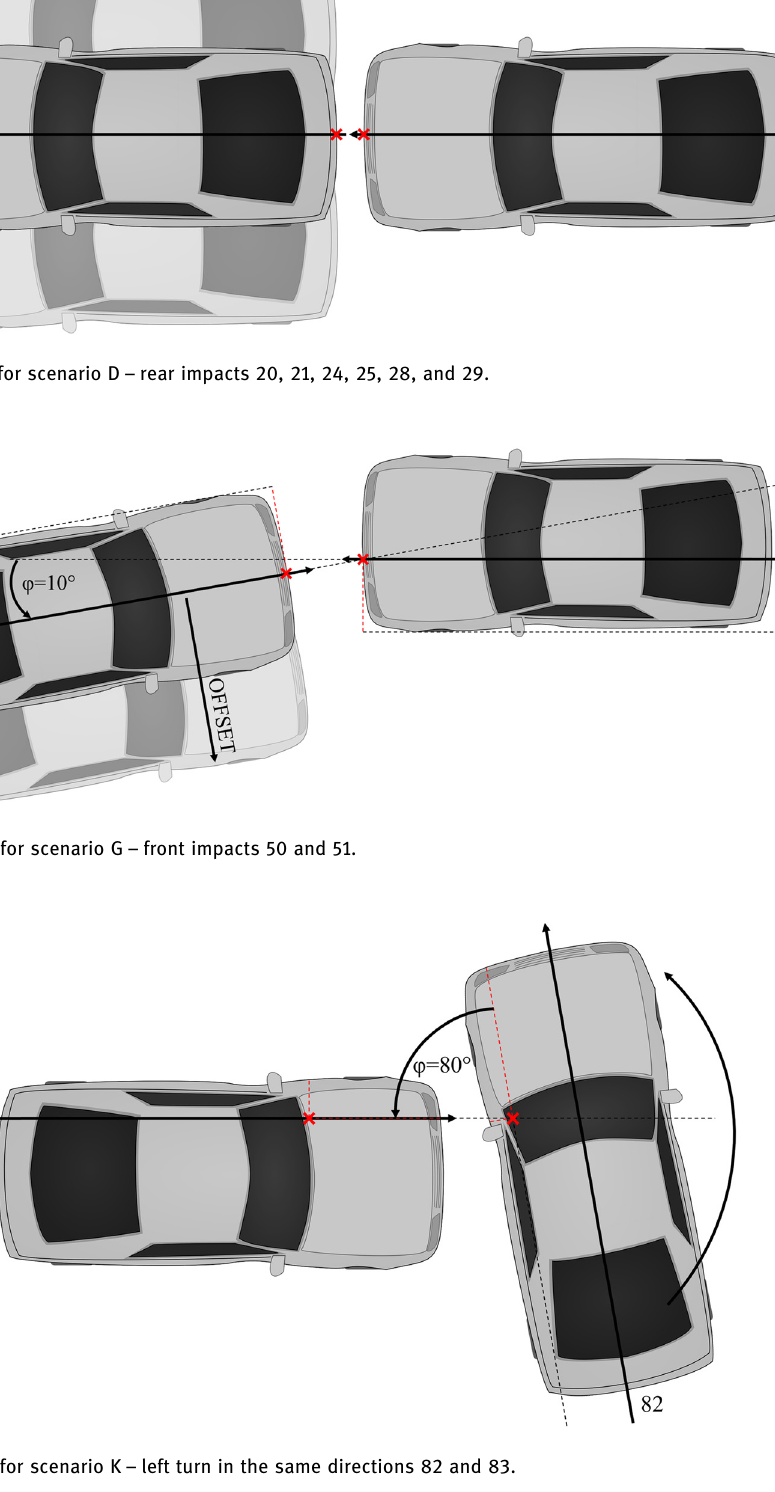
Figure A3: Collision position for scenario K – left turn in the same directions 82 and